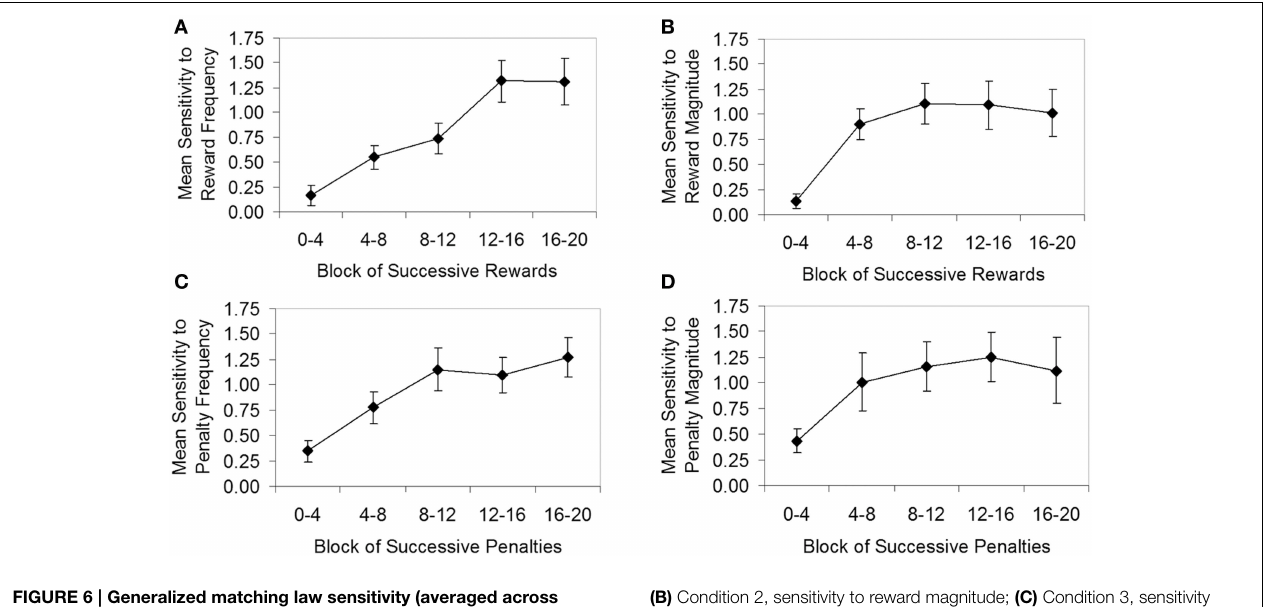
FIGURE 6 | Generalized matching law sensitivity (averaged across participants, N = 30 ) as a function of block for the four conditions of the Auckland Card Task. (A) Condition 1, sensitivity to reward frequency;